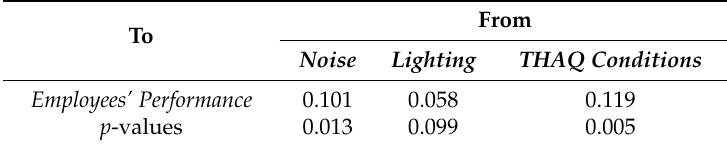
Table 9. Sum of indirect effects.